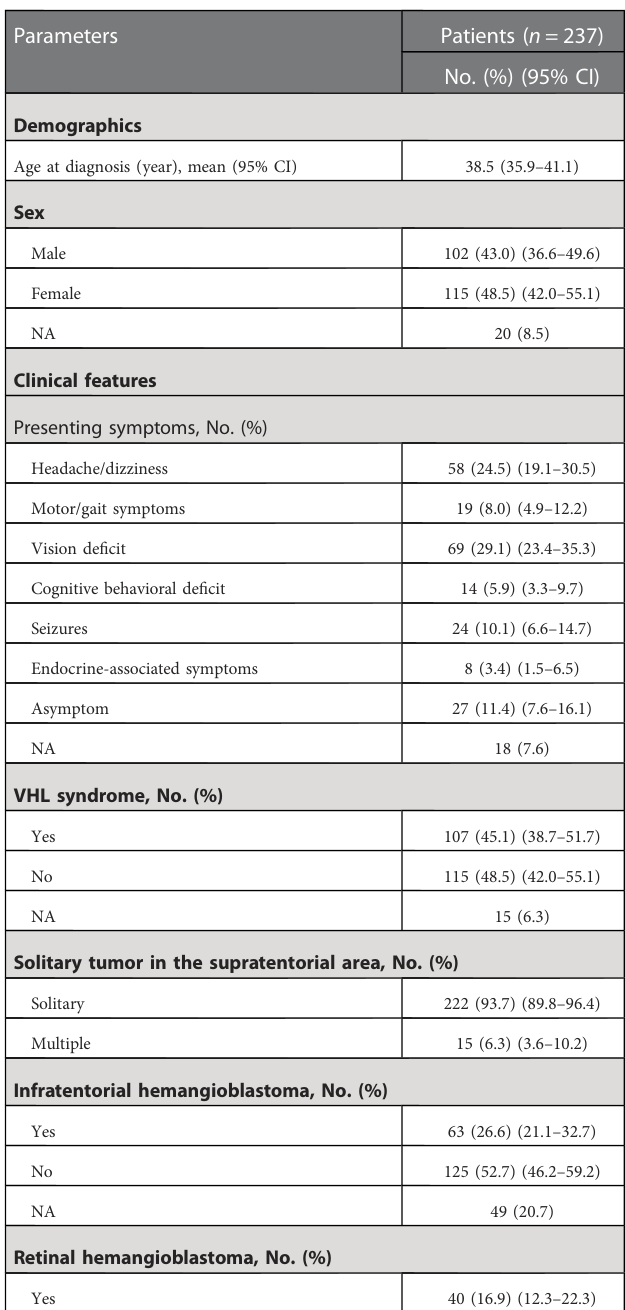
TABLE 1 Clinical characteristics of the study